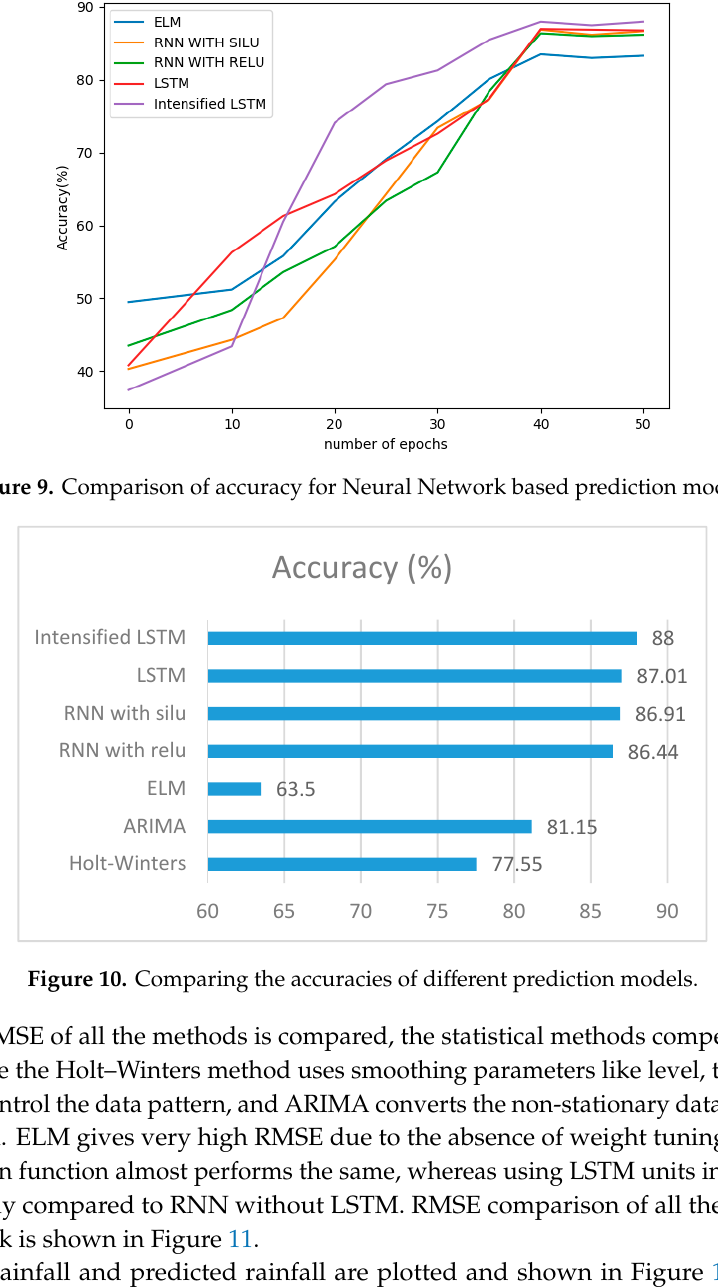
Figure 10. Comparing the accuracies of different prediction models.